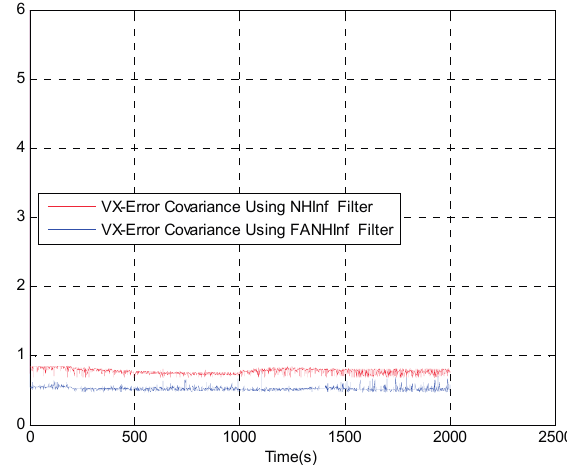
Figure 14. Velocity error covariance in x